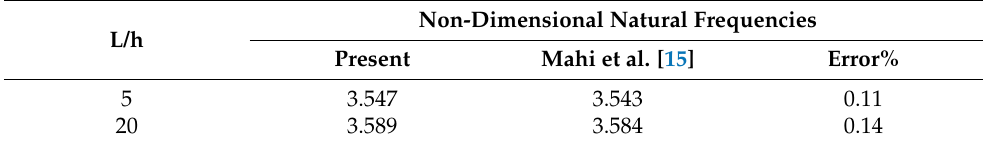
Table 1. Non-dimensional natural frequencies of an exponentially graded beam.